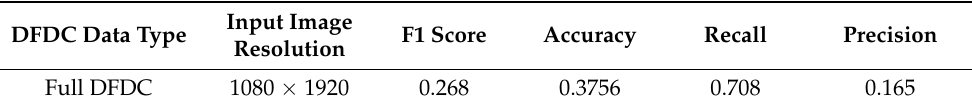
Table 5. Test results obtained with DFDC full dataset when predicted with Model-B that is trained with sample DFDC